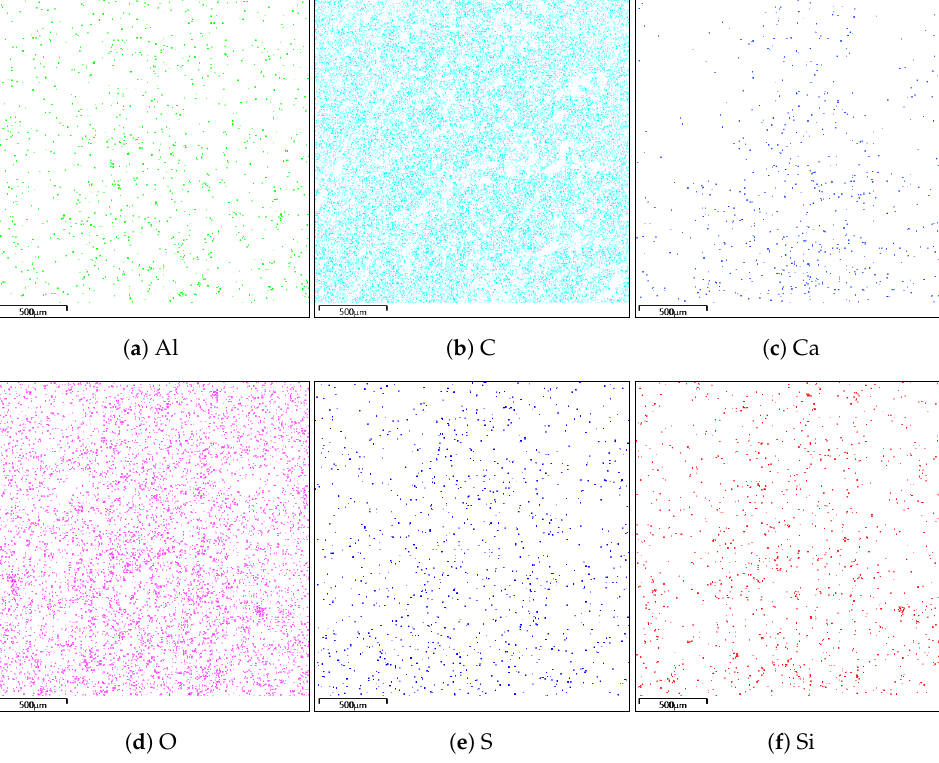
Figure 15. Distribution of individual chemical elements on the cross-sectional area in the material